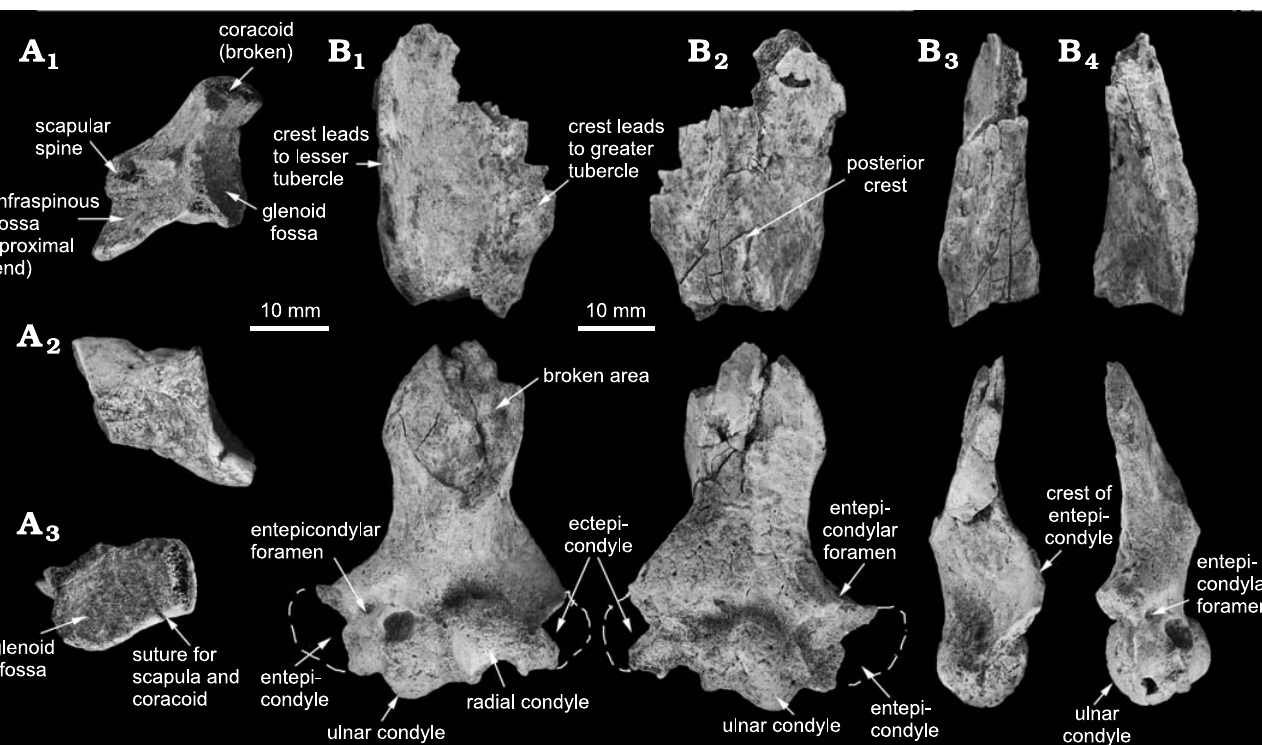
Fig. 11. Fragmentary scapula and humerus of multituberculate mammal Sphenopsalis nobilis Matthew, Granger, and Simpson, 1928 from the upper Paleocene Nomogen beds at the Erden (Urtyn) Obo locality, Inner Mongolia, China. A . IVPP V19030, proximal portion of the right scapula in lateral (A 1 ), medial (A 2 ), and ventral (glenoid fossa) (A 3 ) views. B . IVPP V19031, left humerus in anterior (B 1 ), posterior (B 2 ), lateral (B 3 ), and medial (B 4 ) views. Due to the breakage, the proximal (top) and distal (bottom) portions may not be displayed in their precise anatomical